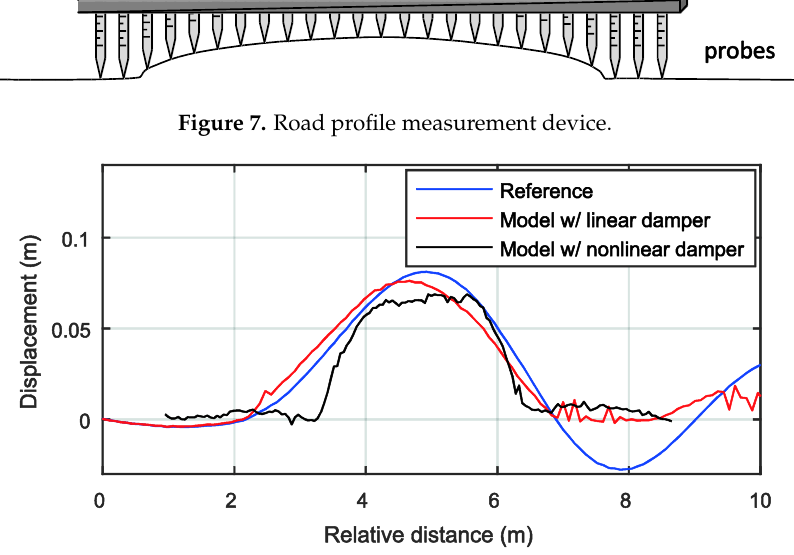
Figure 8. Estimated longitudinal road profile.